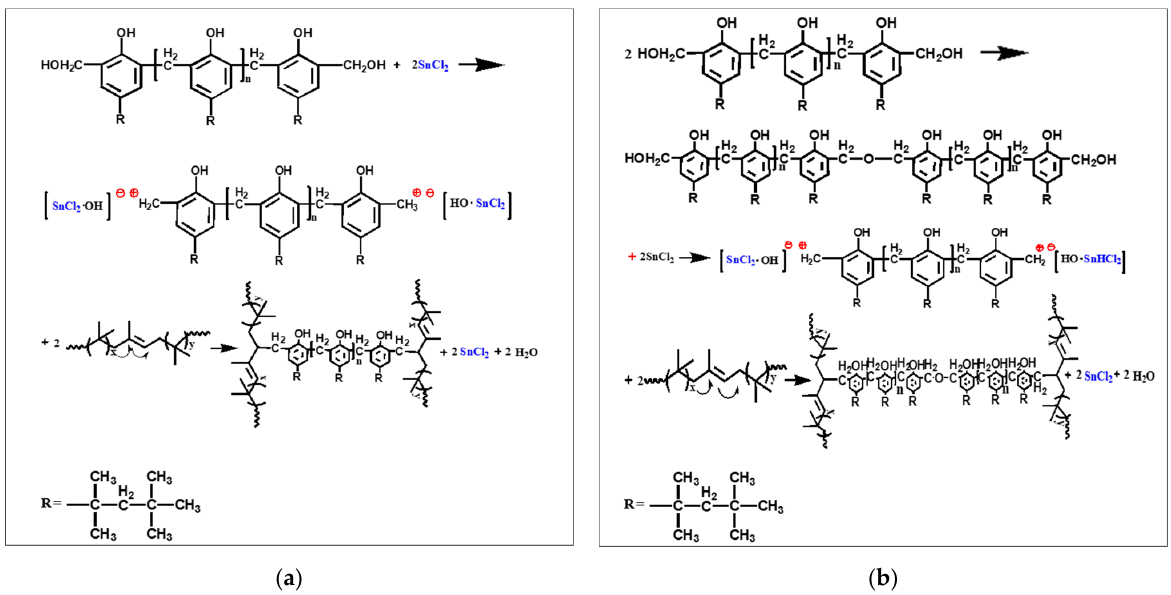
Figure 1. Mechanism of IIR vulcanized by octyl-phenolic resin: ( a ) mechanism of formation of C–C. ( b ) mechanism of formation of C–O–C.